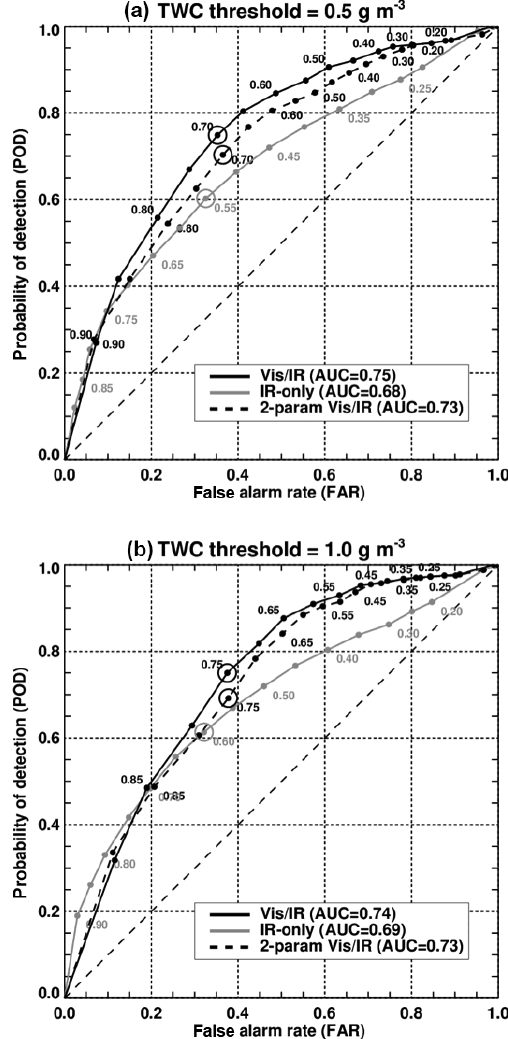
Figure 12. A receiver operating characteristic (ROC) curve show- ing the relationship between POD and FAR for PHIWC thresholds ranging from 0.0 to 1.0 (labeled at 0.1 increments) based on TWC thresholds of 0.5gm − 3 (a) and 1.0gm − 3 (b) . The solid black curve represents the three-parameter PHIWC day and the solid grey curve represents the two-parameter PHIWC night . The dashed black curve represents an algorithm formulation using (cid:49) BTW and dOT analo- gous to PHIWC night , but VIS OT and texture detections in addition to IR OT detections are used to derive dOT. This formulation could be used for daytime HIWC detection in the event that a COD re- trieval product is unavailable. Optimal PHIWC values based on the maximum area underneath the ROC curve (AUC) are circled and the corresponding AUC is provided in the